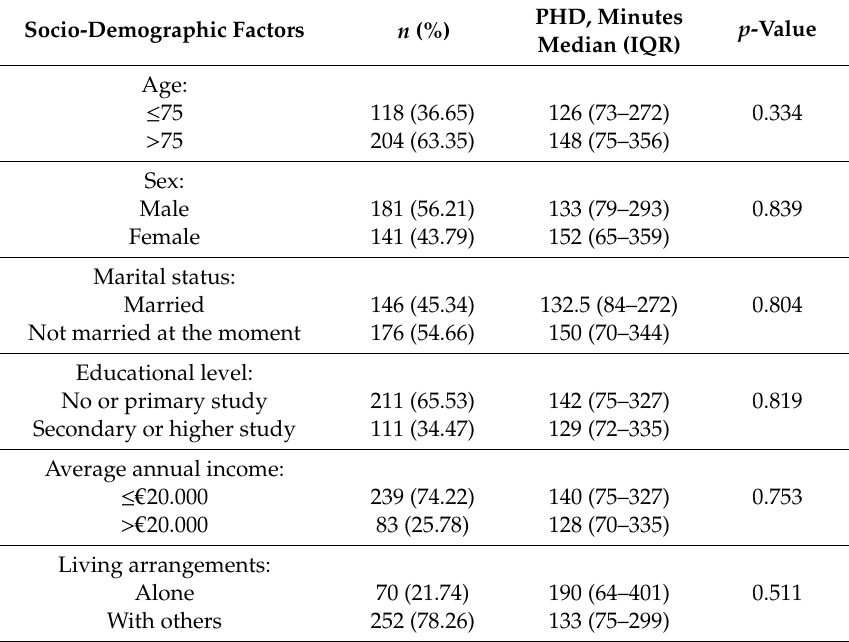
Table 1. Time from symptom onset to hospital arrival by socio-demographic factors.